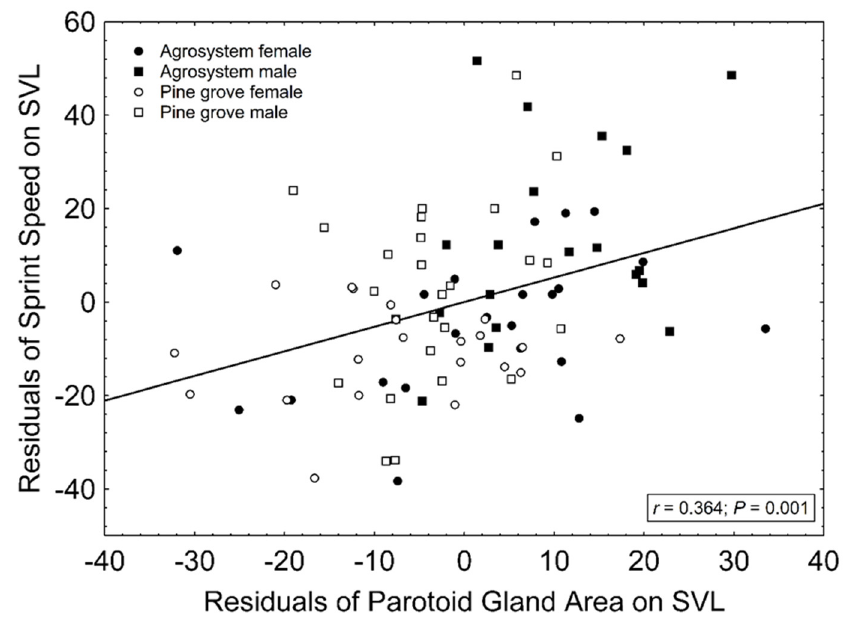
Figure 1. Correlation between the residuals of sprint speed on SVL and the residuals of parotoid gland area on SVL. r and p values are